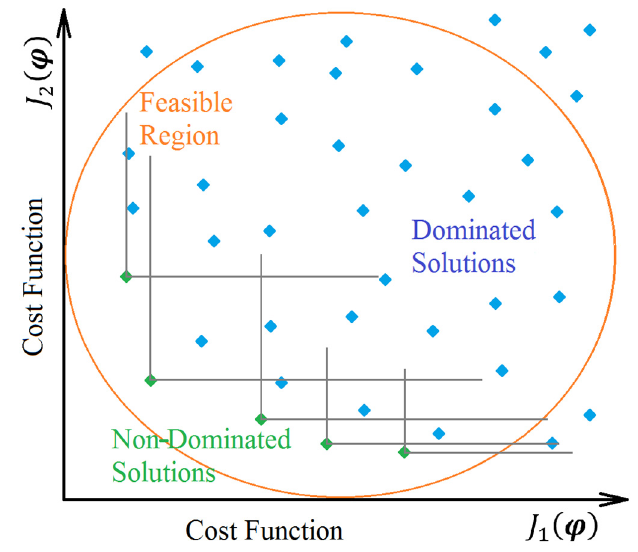
Figure 9. Representation of both non-dominated and dominated solutions in the cost functions domain.